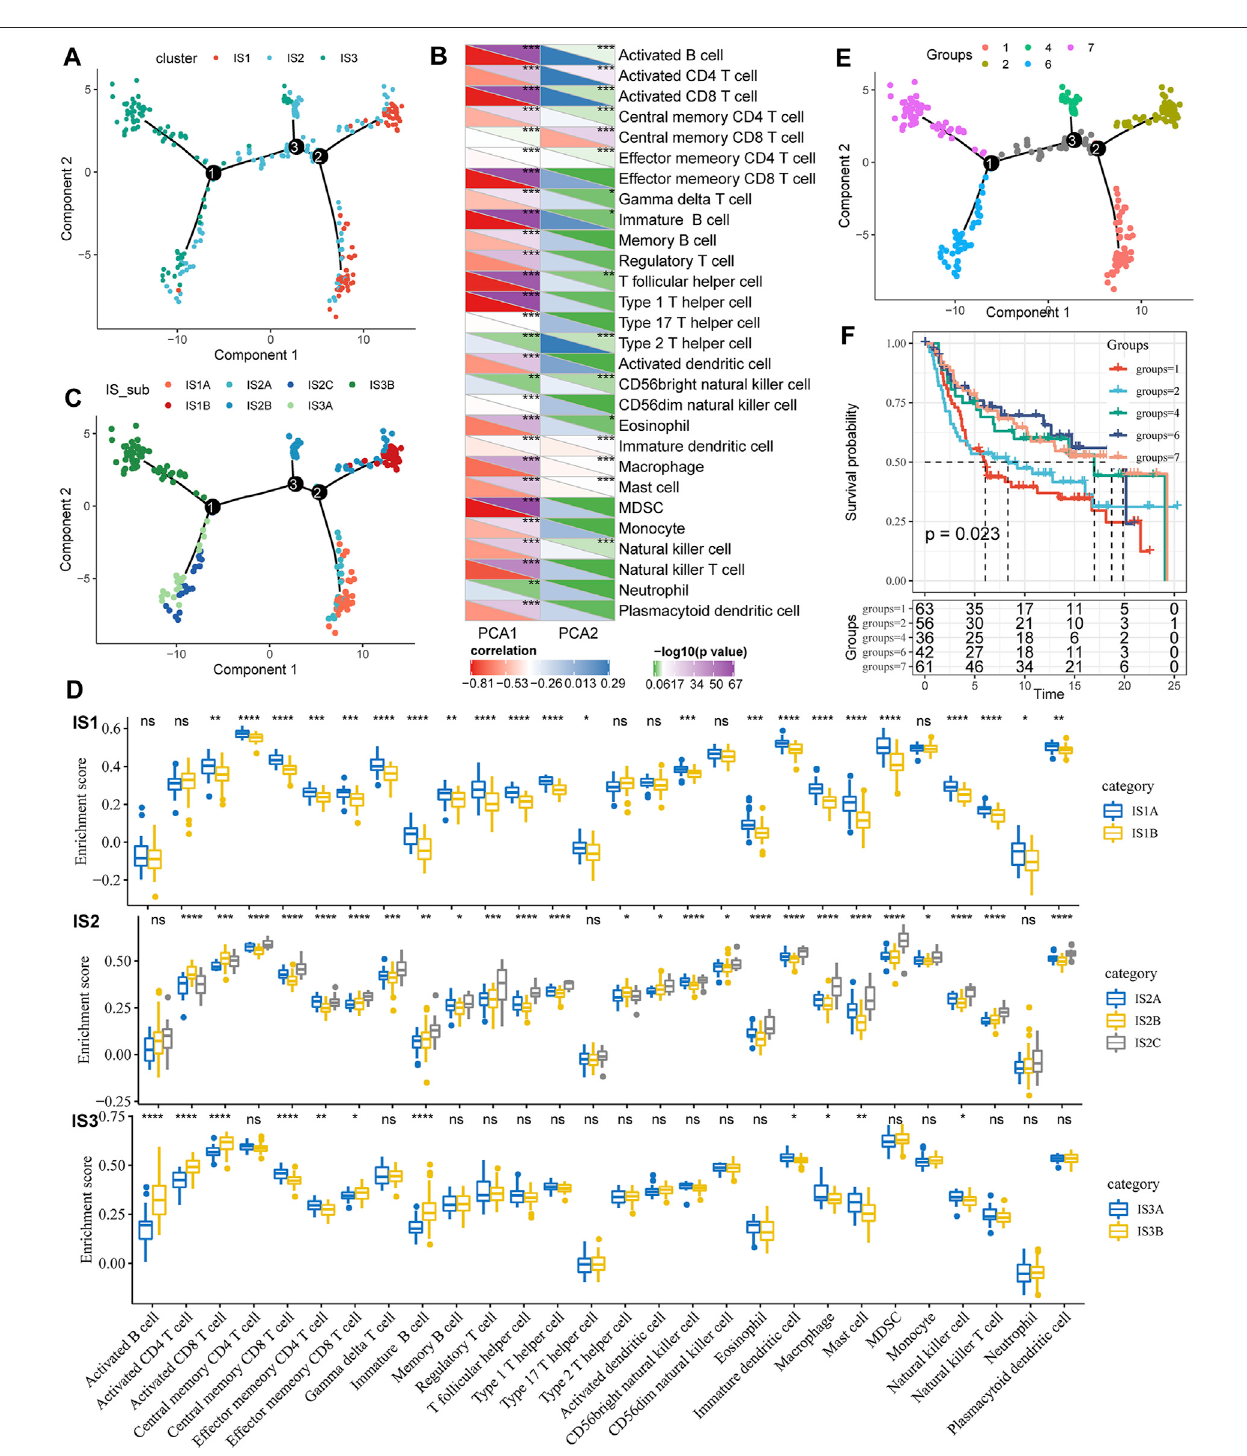
FIGURE6|(A) ImmunelandscapeinTNBC.Eachdotrepresentsasample,andeachcolorrepresentsamolecularsubtype.Thehorizontalaxisrepresentsthe fi rst principal component, while the vertical axis represents the second principal component. (B) Heat map of the correlation between two principal components and 28 immune cell types. (C) Immune landscape and molecular subgroups of three immune subtypes in TNBC. (D) Immune landscapes and samples from two different locations in TNBC. (E) Immune landscape in TNBC. (F) Prognostic differences among samples at different locations in the immune landscape for TNBC.